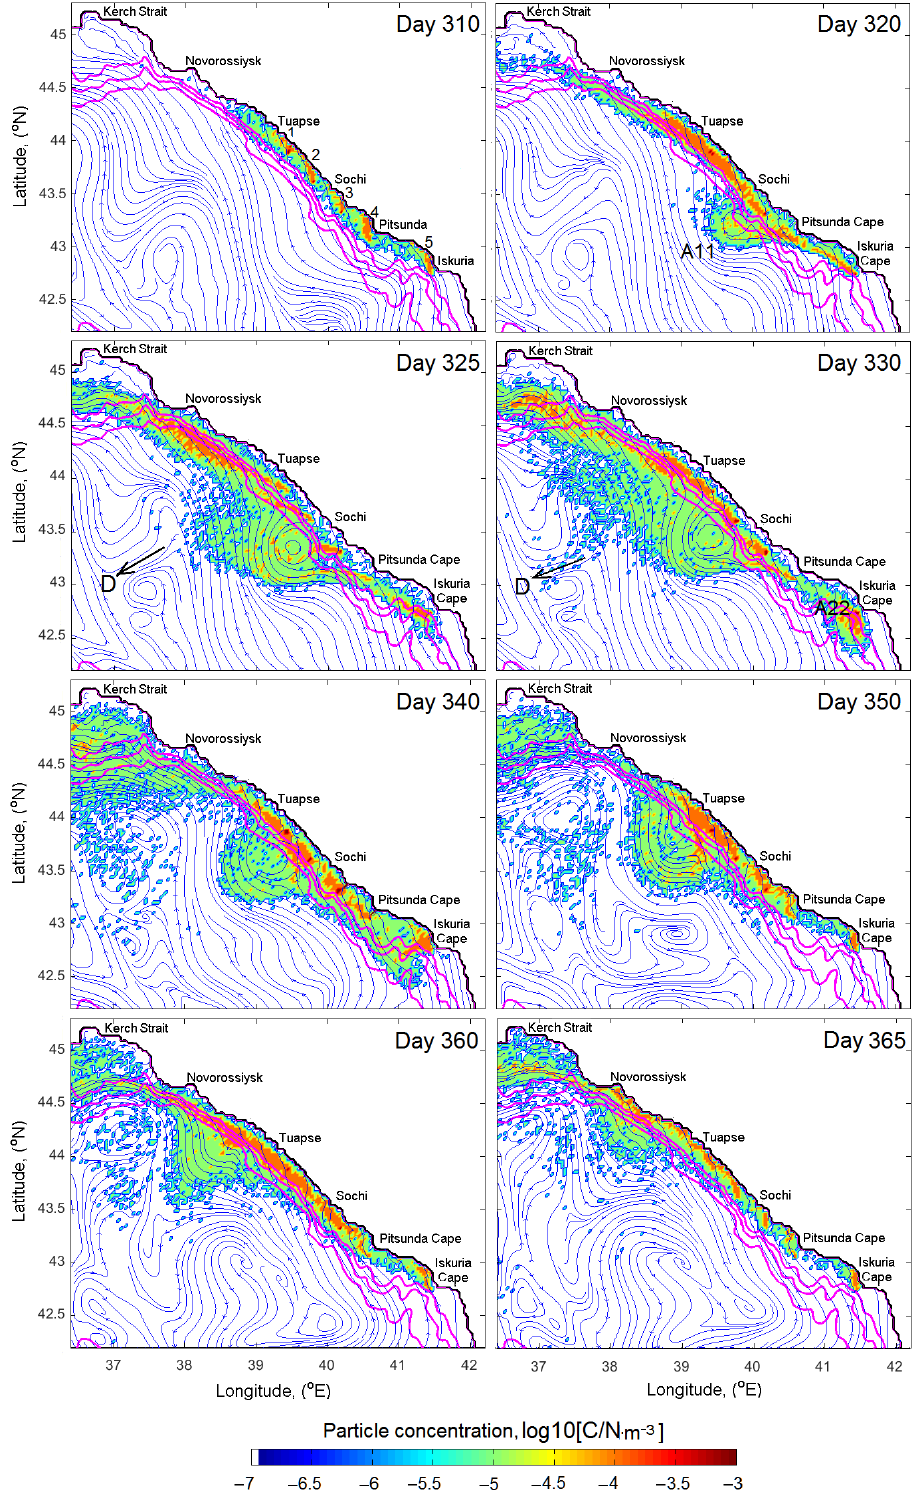
Figure 8. A sequence of planar distributions of particle concentration illustrating the influence of the isolated Caucasian anticyclonic eddy on the particle transport mimicking river plumes. In the panel ‘day 310’, Tuapse, Ashe, Mzymta, Bzyb, and Kodor river mouths are marked by numbers 1, 2, 3, 4, and 5, respectively. Julian days are shown at the top. Magenta lines show isobars 500, 1000, and 1400 m. The arrays D, in the panels ‘day 325’ and ‘day 330’, designate dipole